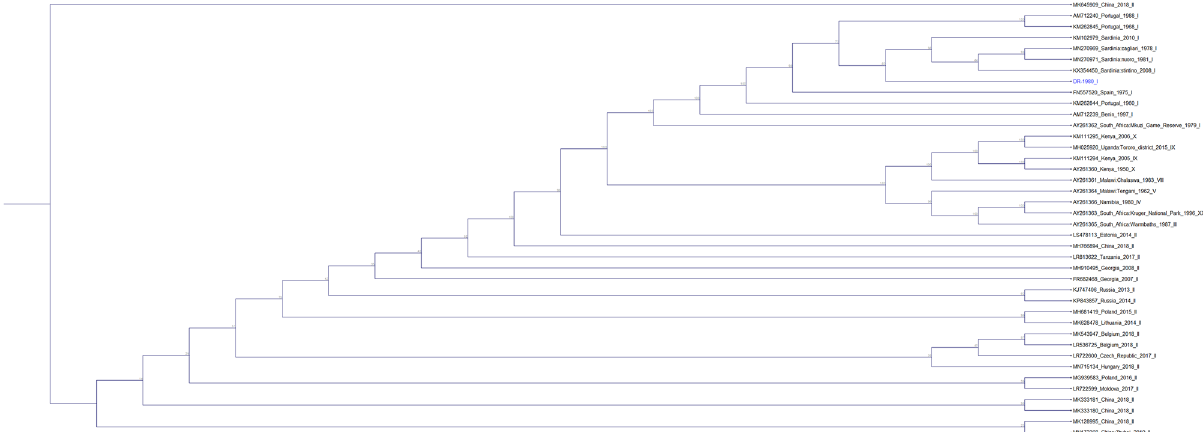
Figure 1. The full-length trees. 40 curated ASFV sequences were aligned to DR-1980 and a cladogram was created using the neighbor joining method and Jukes-Cantor mode with phylogeny inferred using 1000 bootstraps. Bootstrap values are shown at each branch. Genomes are labeled by GenBank accession number region of isolation date of isolation_p72 genotype. DR-1980 is highlighted in blue font .